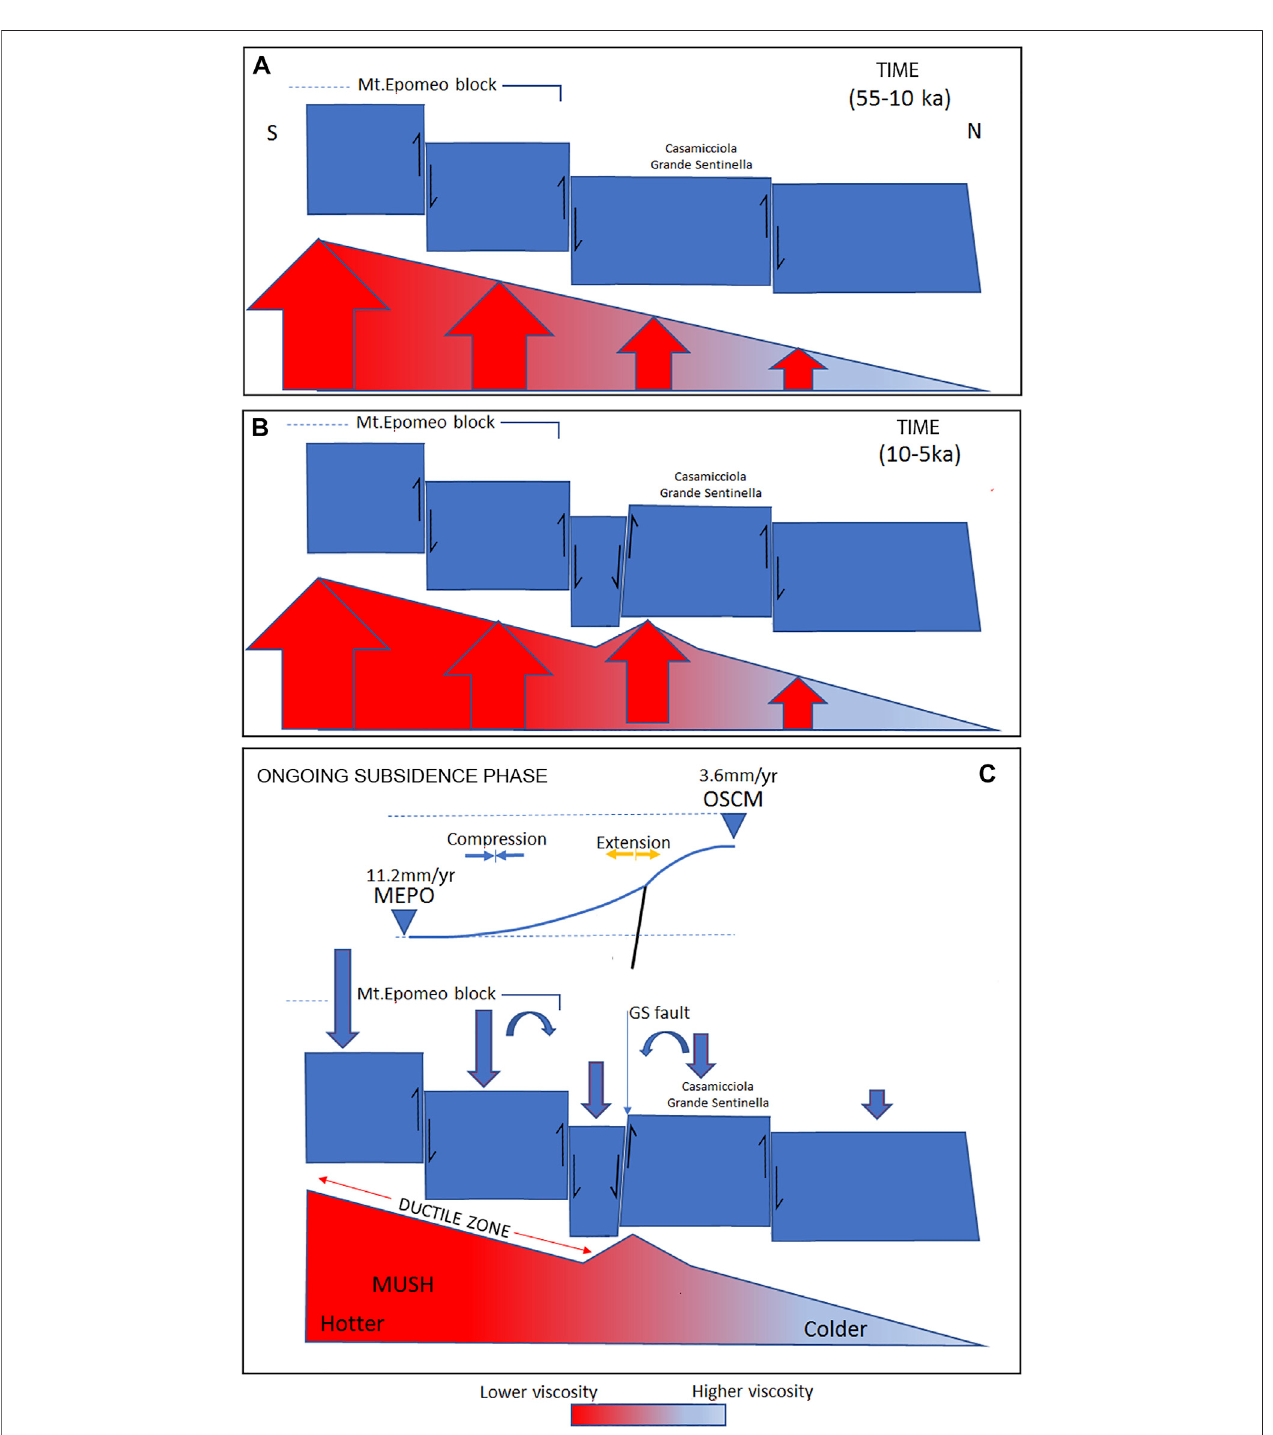
FIGURE 7 | Conceptual sketch of faults formation during the earlier (55 – 10 ka) and late (10 – 5 ka) stage of the resurgence [panels (A,B) , respectively] and the present dynamic that is characterized by subsidence panel (C) . Red arrows in the panel A and B indicate the magma pressure exerted on the rigid block: increasing dimensionindicateslargerpressure.Inthelatestageoftheresurgence,furthermagmaarrivedinthesystemanddislocatedtheblockofGrandeSentinellaupwardalong afaultwhichloweredasmallsouthernblockformingalocalhost-graben-likestructurepanel (B) .Panel (C) showsaqualitativedeformationpro fi leasfunctionofthe differential downward movement (blue arrows) between the MEPO and OSCM GPS stations. Curved arrows indicate the slight sinking of the blocks inferred from horizontal component of the GPS benchmarks. NOT TO SCALE (see text for details).